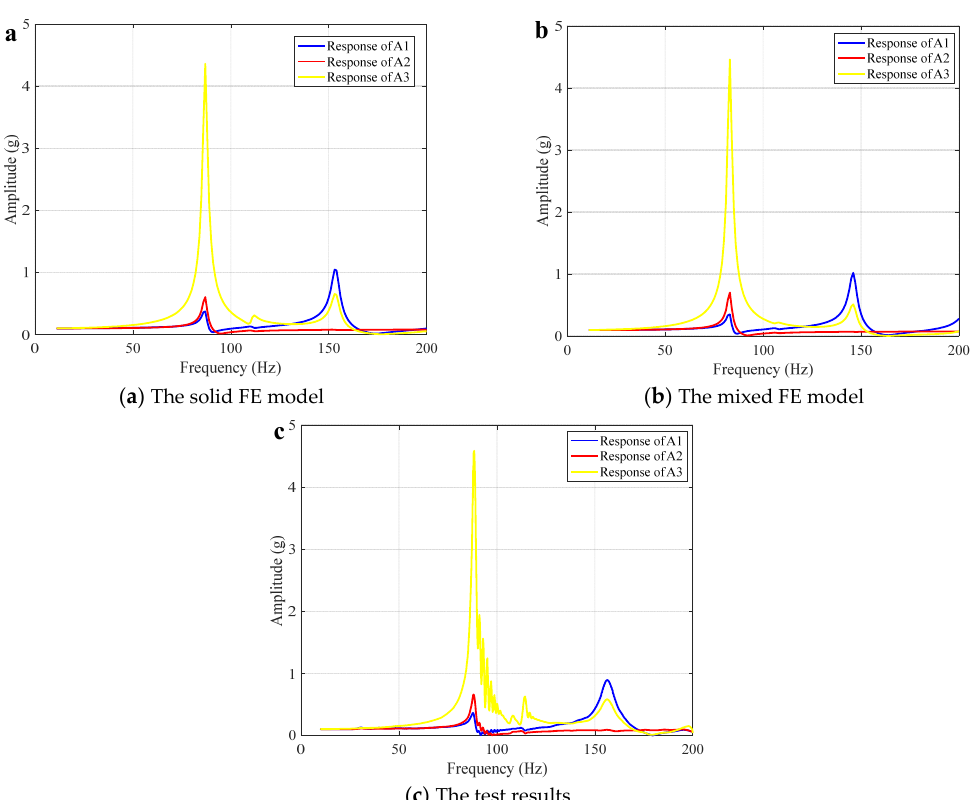
Figure 13. Frequency sweep curves for two FE models of experiment rack simulator and measured results. Table 7. Simulation and experimental vibration response under sweep frequency.